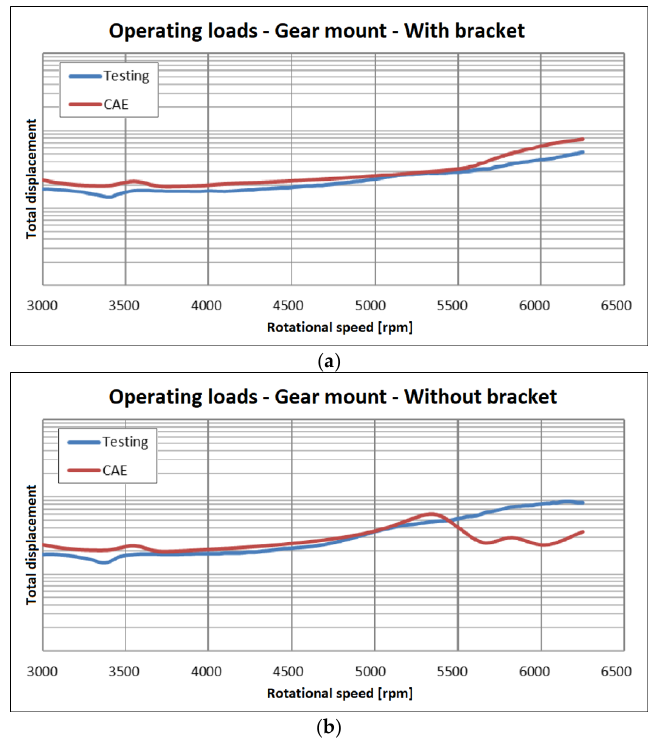
Figure 8. Experimental/numerical comparison in terms of displacements at the gearbox mount ( a ) with and ( b ) without consideration of the bracket highlighted in Figure 3.